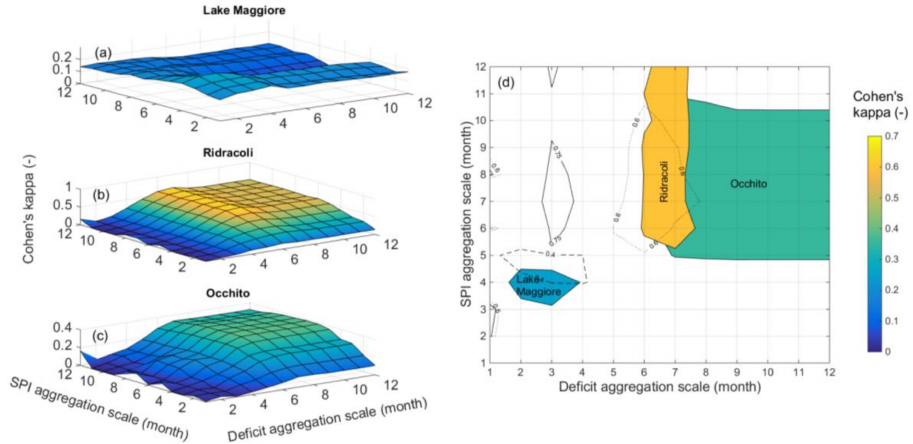
Figure 10. Panels ( a – c ) Cohen’s k coefficients for the three case studies. ( d ) Contour line Cohen’s k = 0.25 contour line for Lake Maggiore (solid line), contour line correlation = 0.4 for Lake Maggiore (dashed line); contour line Cohen’s k = 0.6 for Ridracoli (solid line), contour line correlation = 0.6 for Ridracoli (dashed line); contour line full Cohen’s kappa = 0.35 for Occhito (solid line), contour line correlation = 0.75 for Occhito (solid